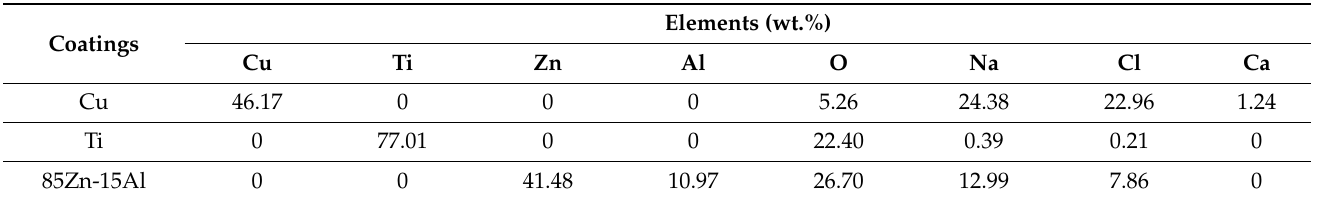
Table 5. EDS analysis of corrosion products formed in 5 wt.% NaCl solution after 28 days of immersion. Elements Coatings